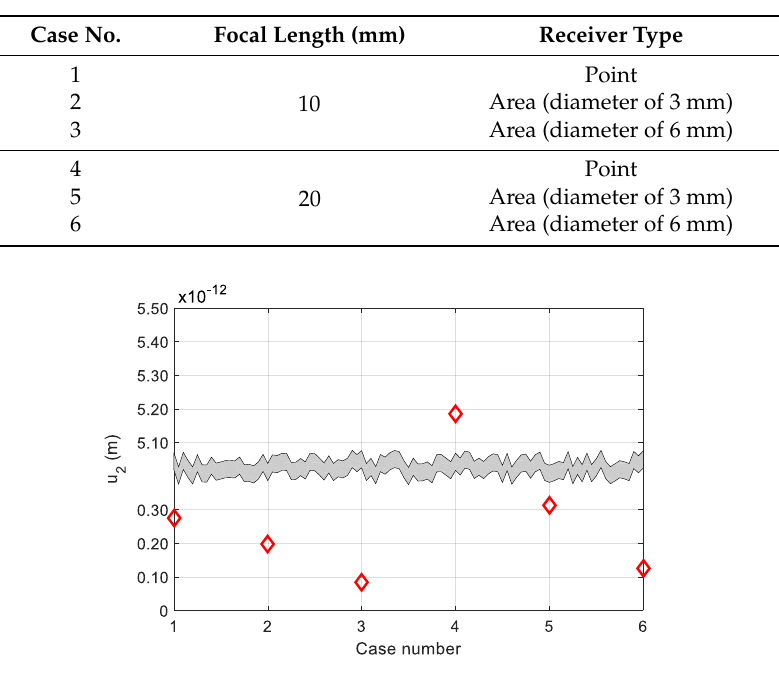
Figure 5. Dependence of pulse-echo SHG on focal length and receiver size.